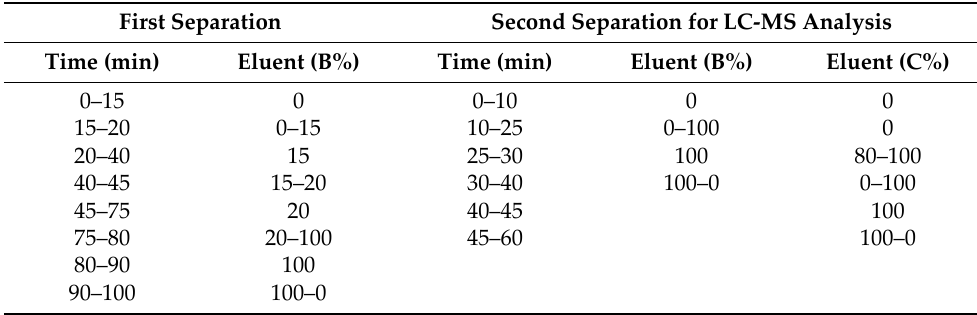
Table 1. HPLC elution schedules for the pepsin‑digested